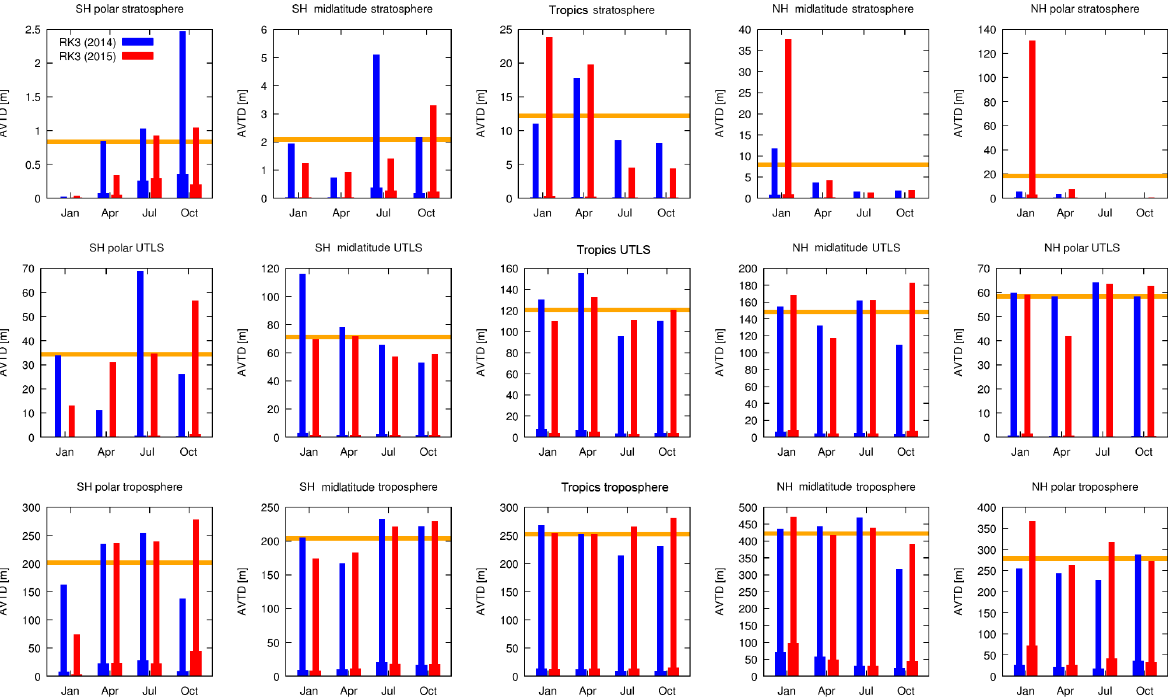
Figure 6. Same as Fig. 5 but for vertical transport deviations. Error limits based on diffusion are about 1300m for the troposphere and 415m for the stratosphere, which is beyond the AVTD ranges shown